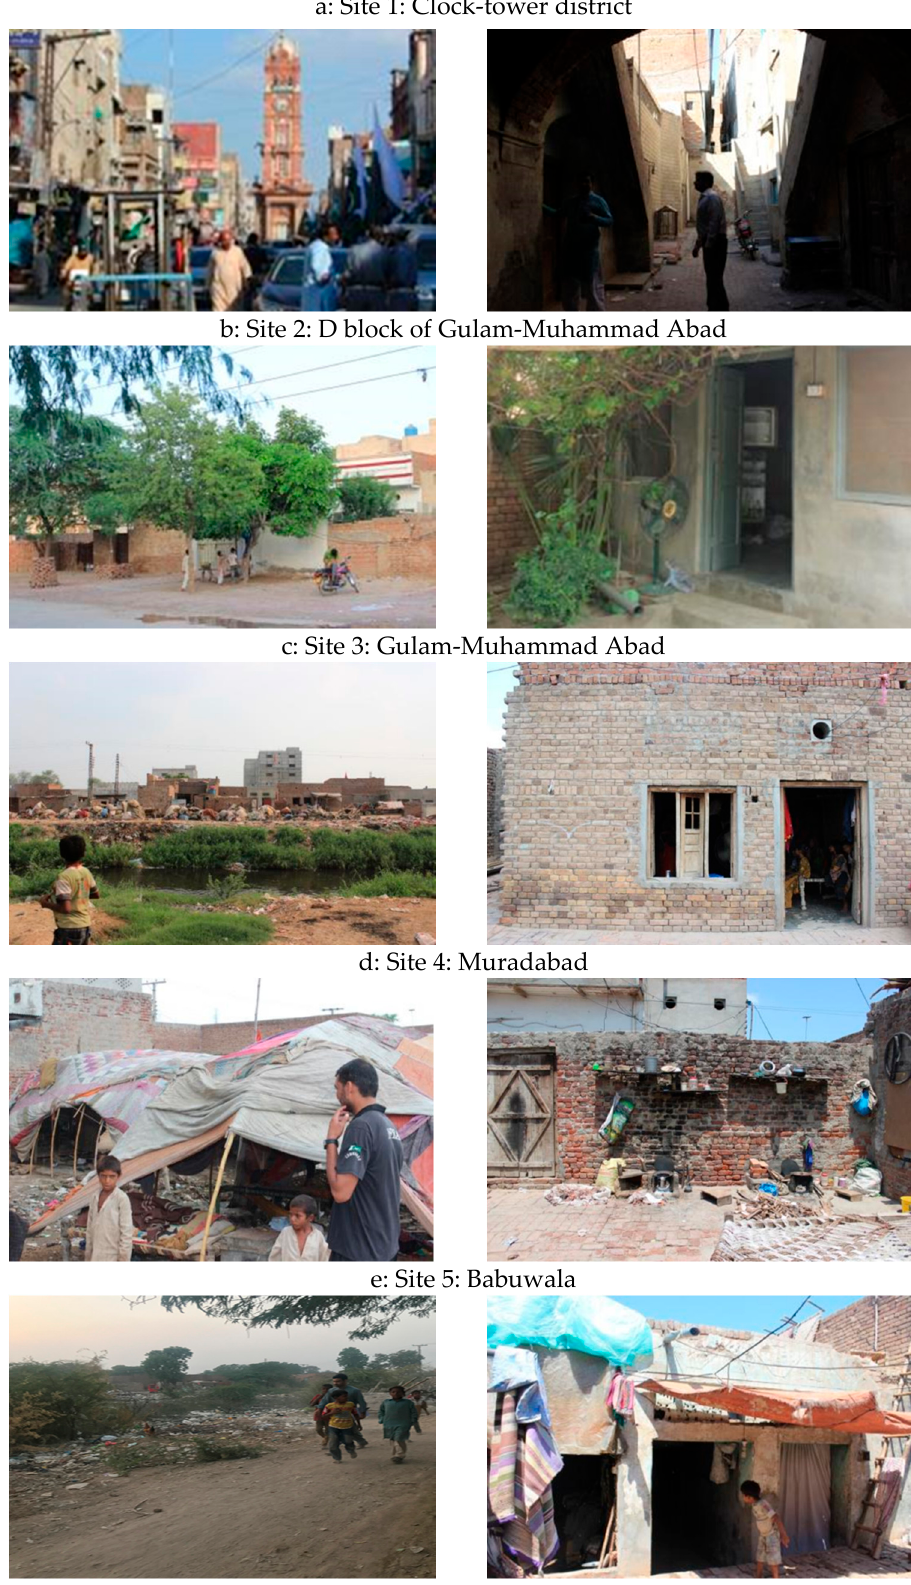
Figure 3. Snapshots of the neighborhood ( left ) and indoor conditions ( right ) of ( a ) Site 1: The clock tower district; ( b ) Site 2: D block of Gulam-Muhammad Abad; ( c ) Site 3: Gulam-Muhammad Abad; ( d ) Site 4: Muradabad; and ( e ) Site 5: Babuwala.